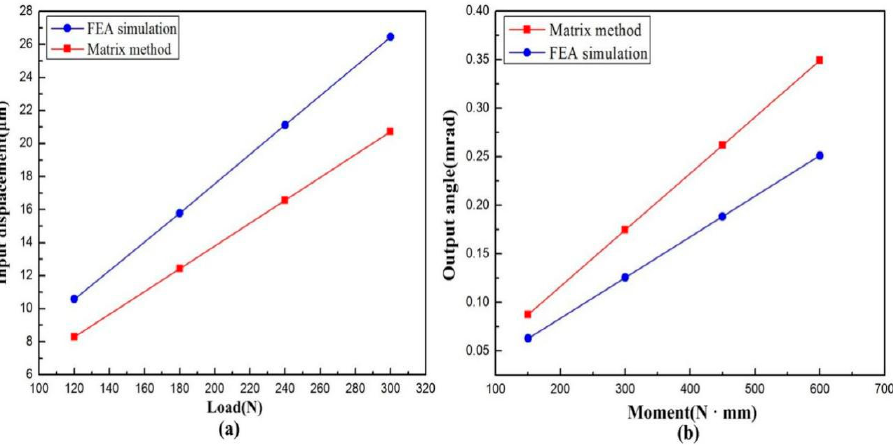
Figure 16. Force-displacement curves of ( a ) input displacement and ( b ) output angle.